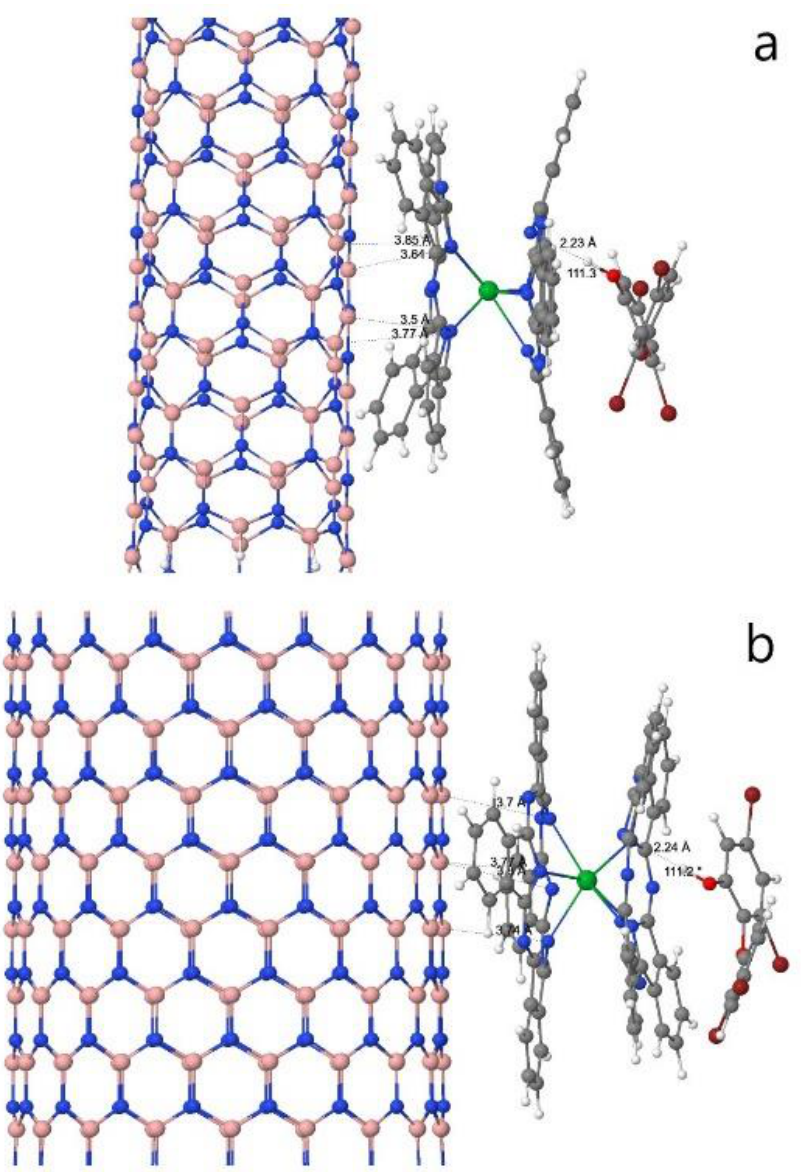
Figure 4. Equilibrium structures of 6-OH-BDE-47 (6ohbde47) adsorbed on the zigzag ( a ) (9,0) and ( b ) (18,0) boron nitride nanotubes decorated with YbPc 2 complex.